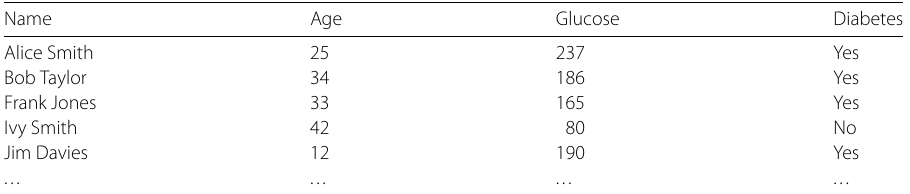
Table 1 Exemplar sensitive